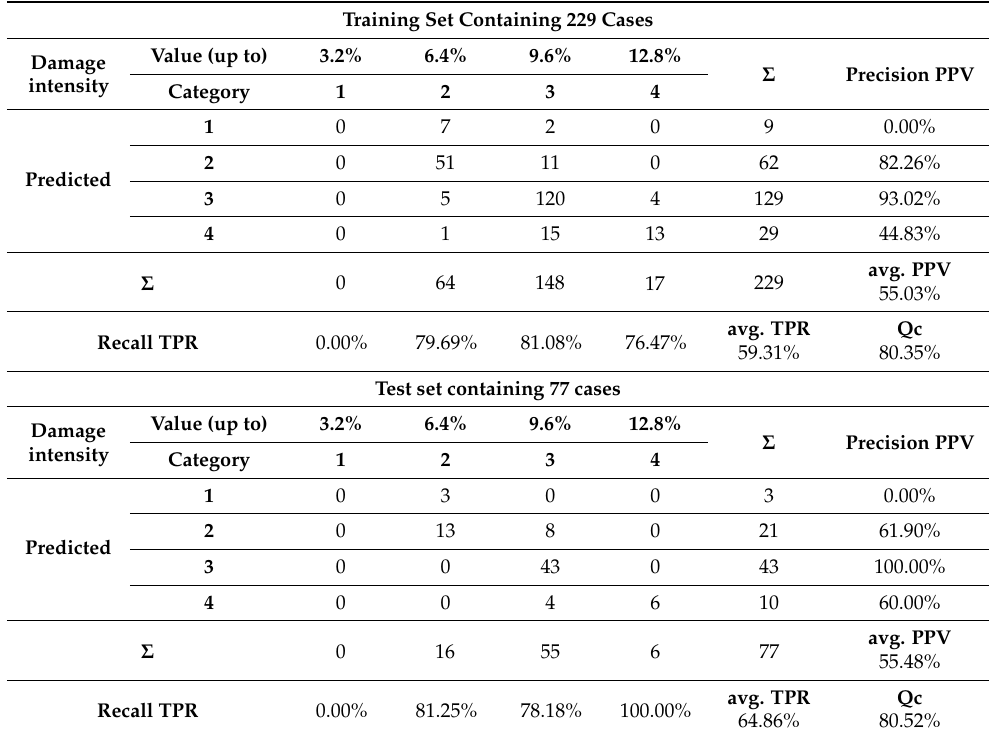
Table 3. Confusion matrix for the CNN classifier—quality of classification, average precision, and average recall for training and test sets.